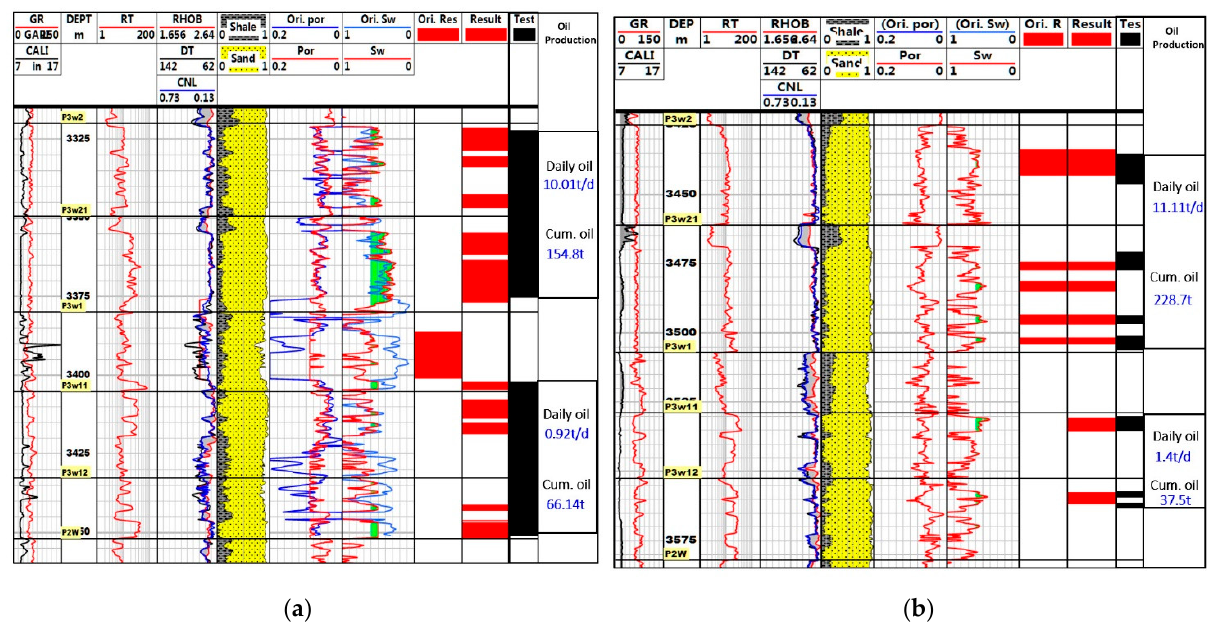
Figure 13. The plot of the logging interpretation results: ( a ) Well XX046; ( b ) Well